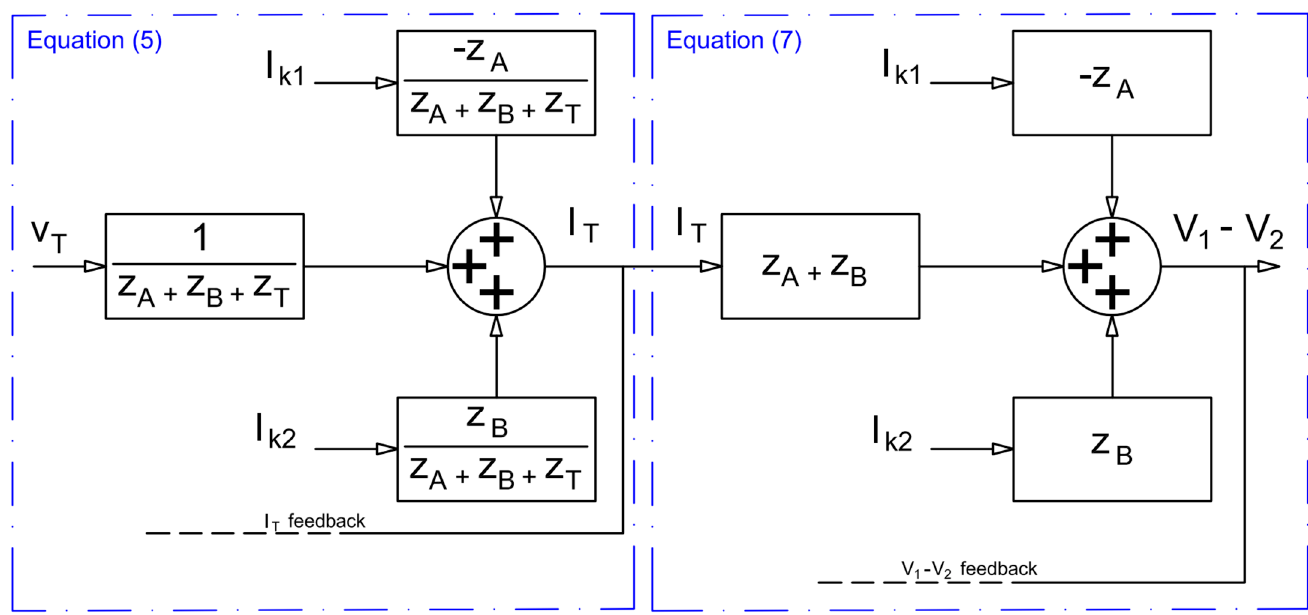
Figure 6. Complete system representation used in the controllers with load disturbances.